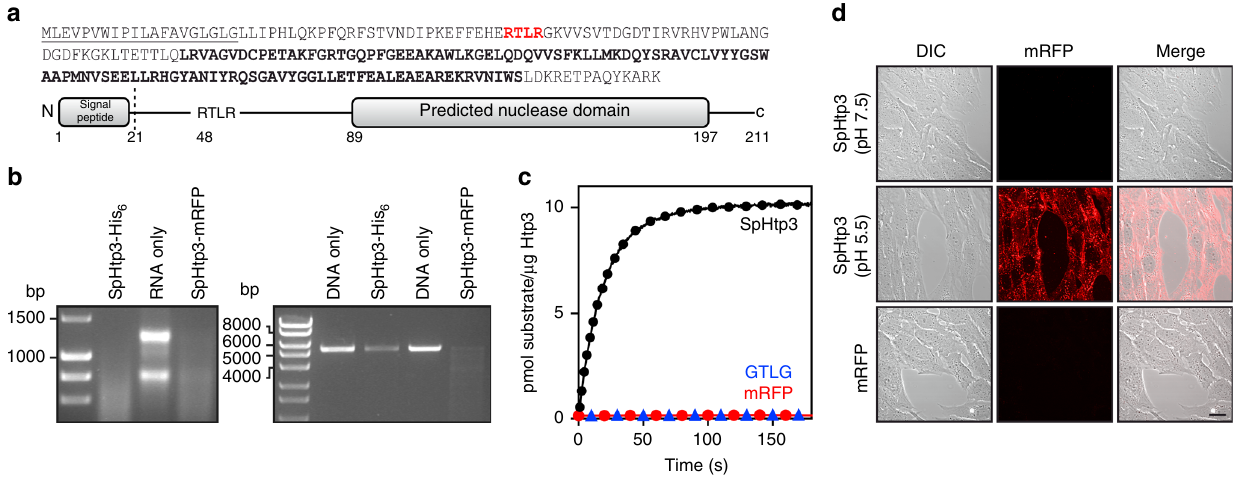
Fig. 2 SpHtp3 is a self-translocating nuclease. a Amino acid sequence of SpHtp3 (top), including the secretion signal (M1-G21, underlined), the RxLR sequence (R48-R51, red) and the predicted nuclease domain (L89-S197, bold). Protein domain structure of SpHtp3 (bottom). b Visualisation of RNA (left, RTG-2 cell RNA) and DNA (right, linearised pET21b) degrading activities of SpHtp3-His 6 and SpHtp3-mRFP ( n = 3). c Real-time ribonuclease activity assessment of SpHtp3 wt (black) compared to a negative control (SpHtp1-mRFP, red) and a non-functional mutant of SpHtp3 (GTLG, blue) with RNaseAlert ® ( n = 2). d Autonomous translocation activity of recombinant SpHtp3-mRFP into living RTG-2 cells at pH 7.5 and 5.5. The control (mRFP only) does not show any translocation. Scale bar: 20 µ m ( n =